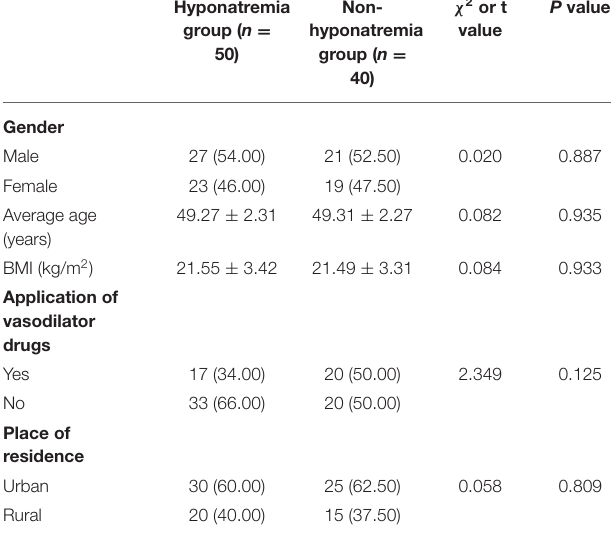
TABLE 2 | Etiology analysis of the patients with hyponatremia [n (%)]. Hyponatremia group ( n